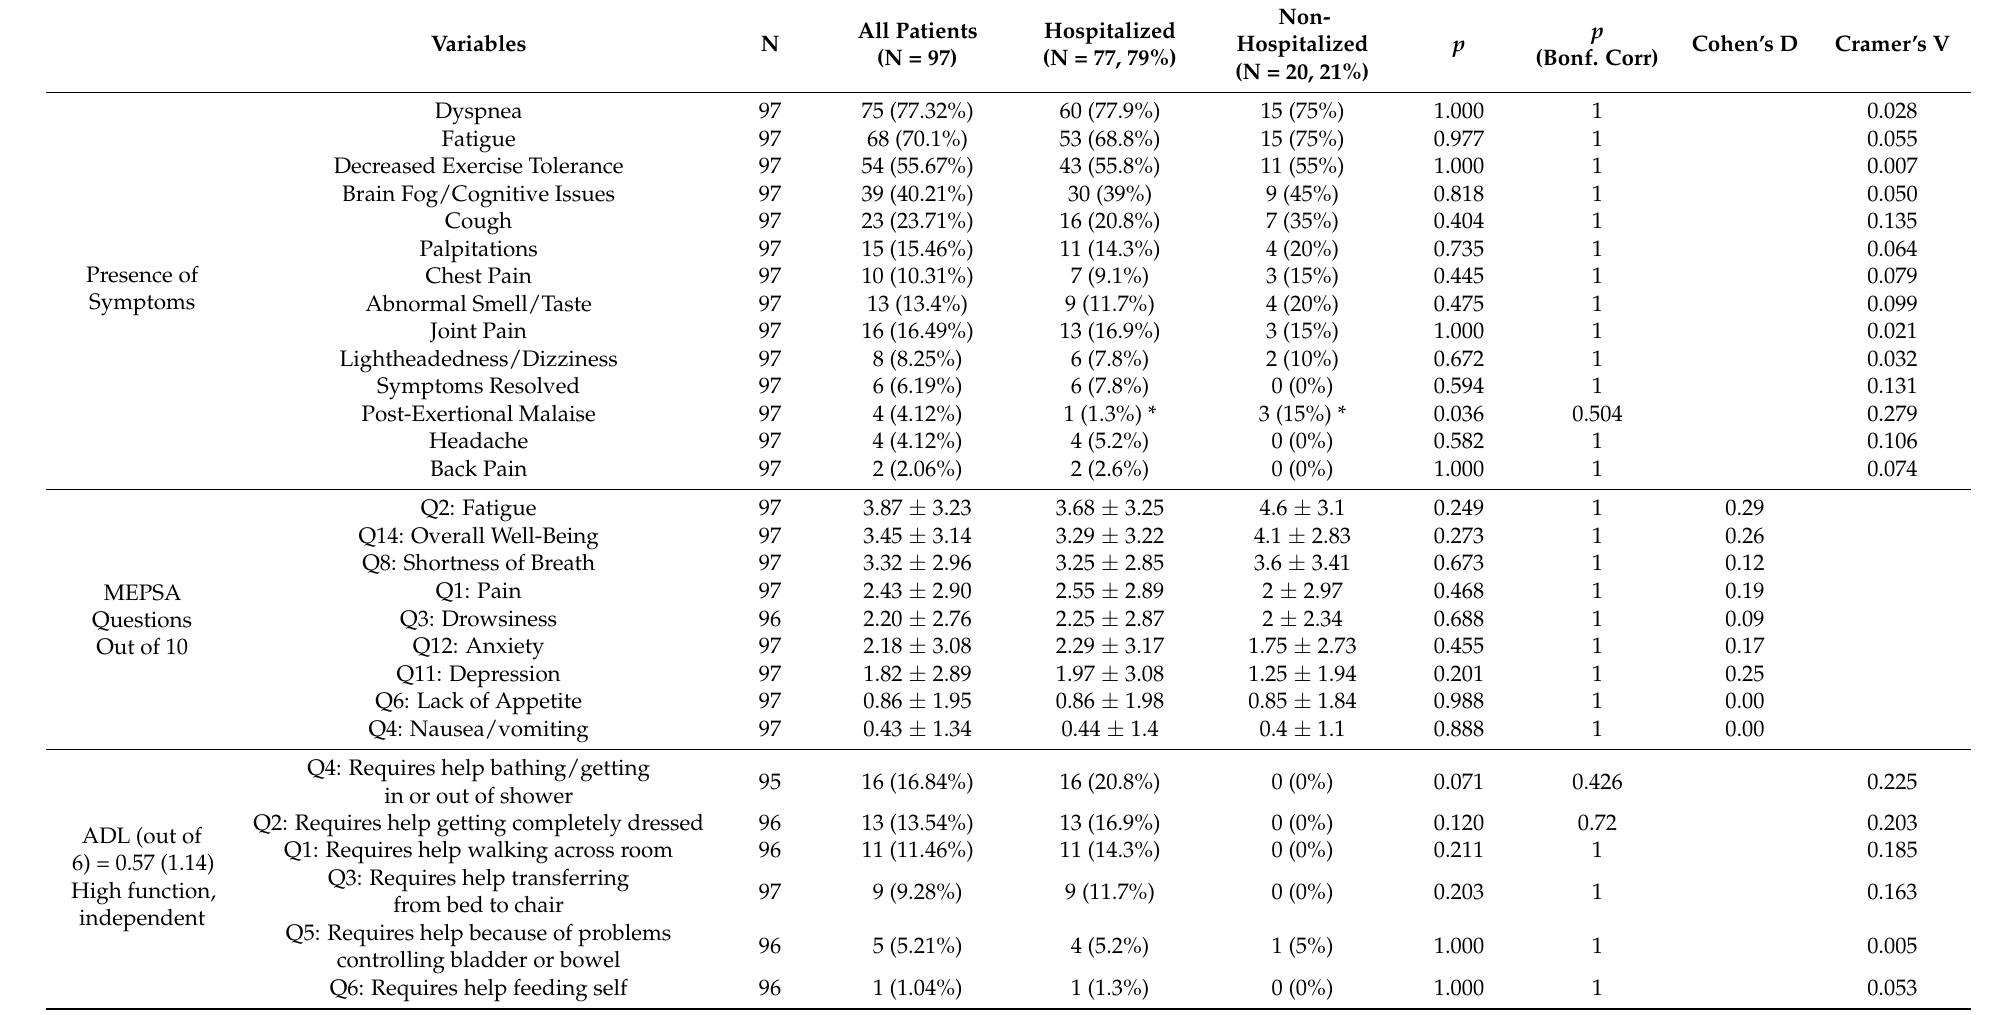
Table 2. Symptoms, MEPSA, ADL, IADL, frailty and neuropsychiatric test scores of CORE patients (mean ± SD or N (%), N = 97). Continuous variables: t